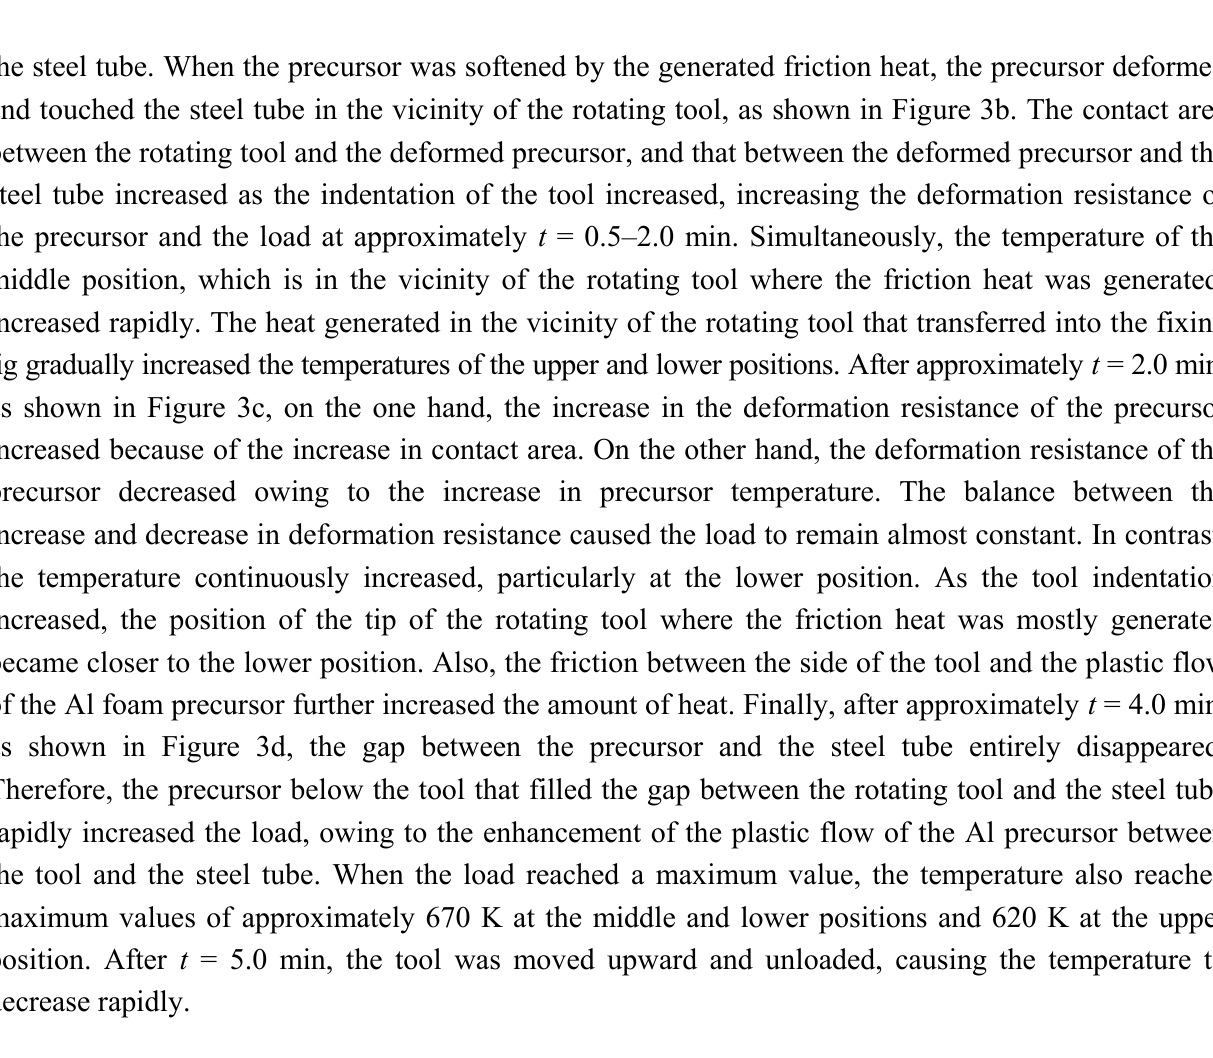
Figure 2. Variations in indentation load P and jig temperature T with respect to indentation time t during friction welding. Temperature was observed at the upper, middle and lower positions of the